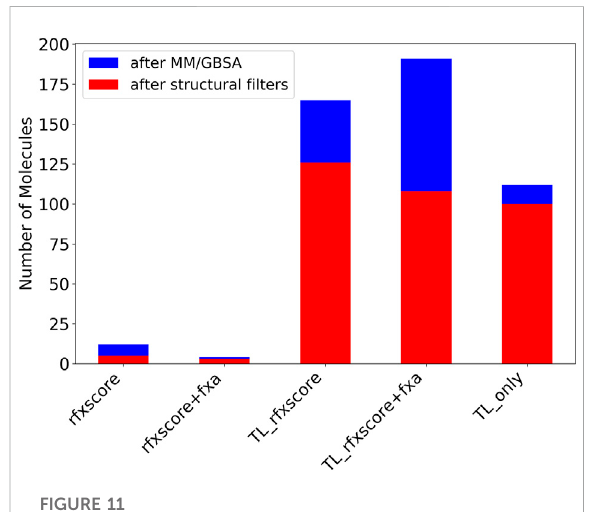
FIGURE 11 Number of molecules after MM/GBSA (blue + red) and structural fi lters